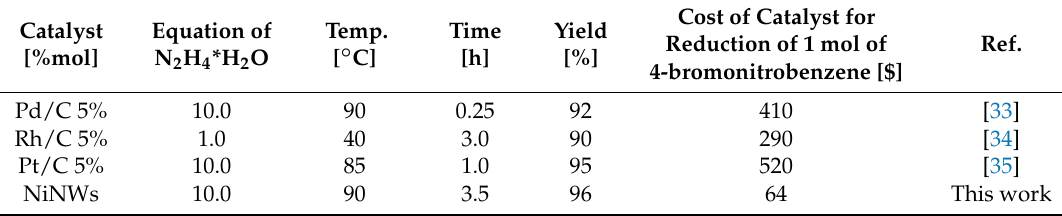
Table 4. Comparison of NiNWs and other traditional catalytic systems used for reduction of nitroarenes a